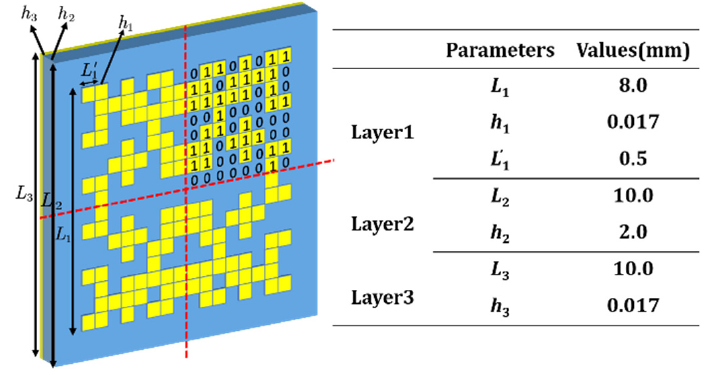
Figure 2. Schematic illustration of a meta-atom structure.